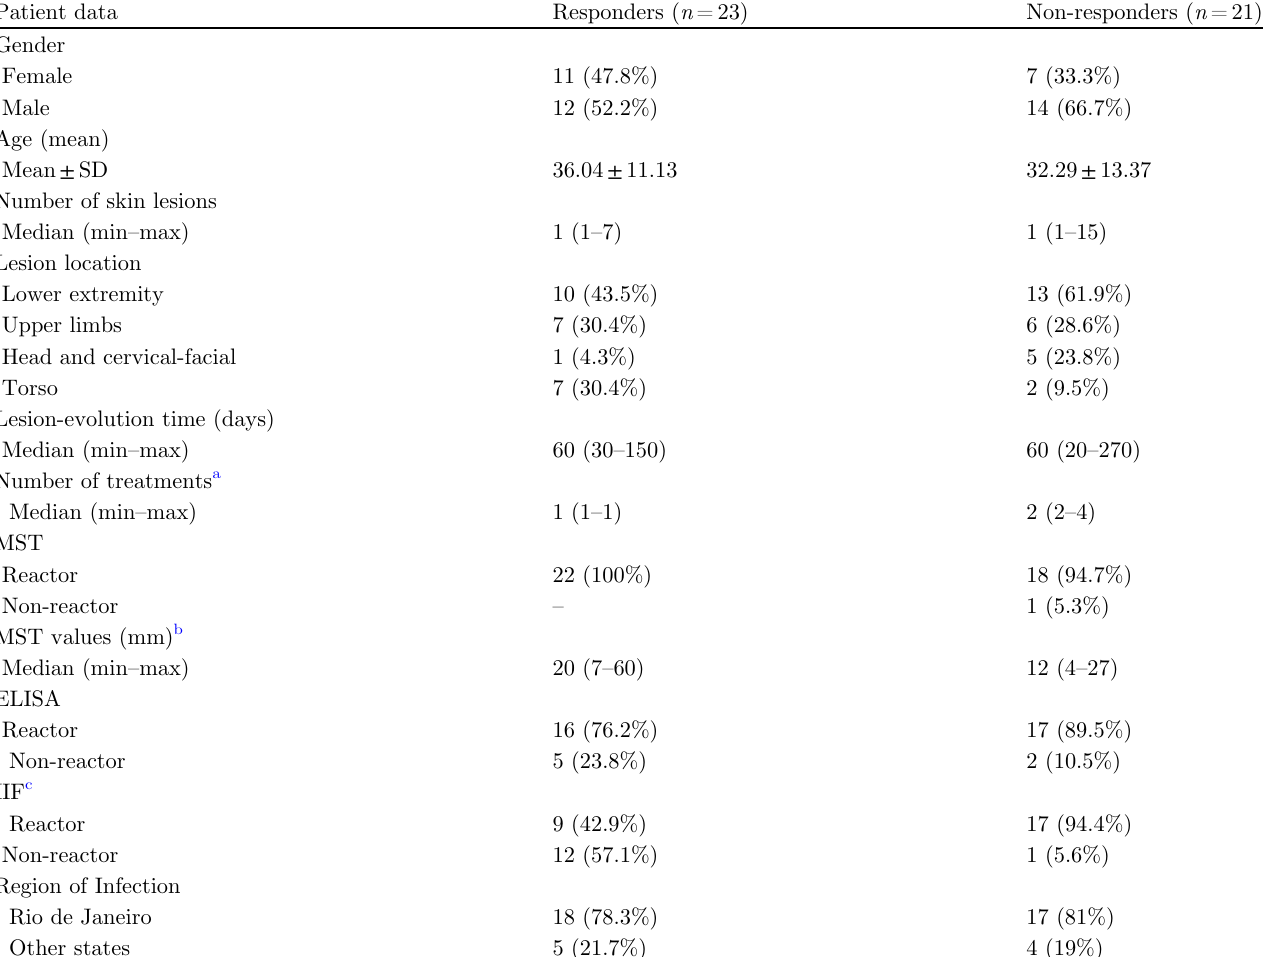
Table 1. Comparison between clinical and geographic data of the responder and non-responder groups involved in the